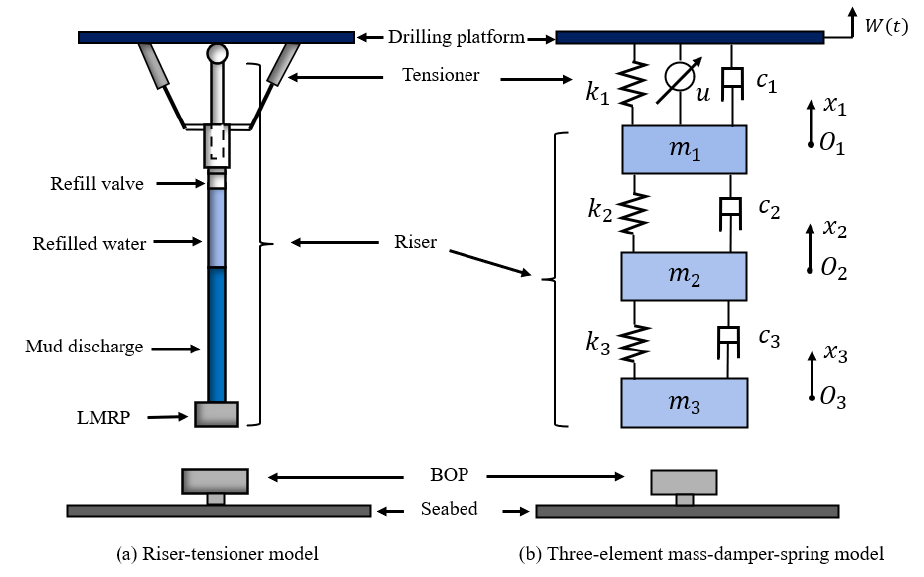
Figure 1. A riser-tension recoil control system model. Adapted with permission from [23,31]. 2020, 2021,